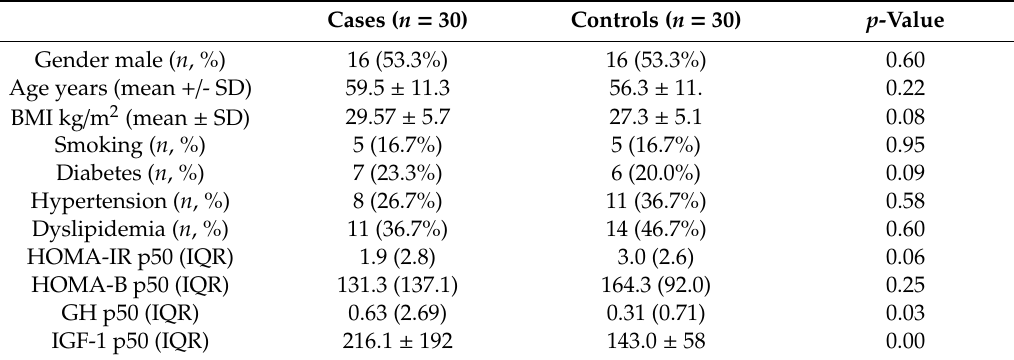
Table 1. Baseline characteristics of acromegaly (ACRO) and matched controls.